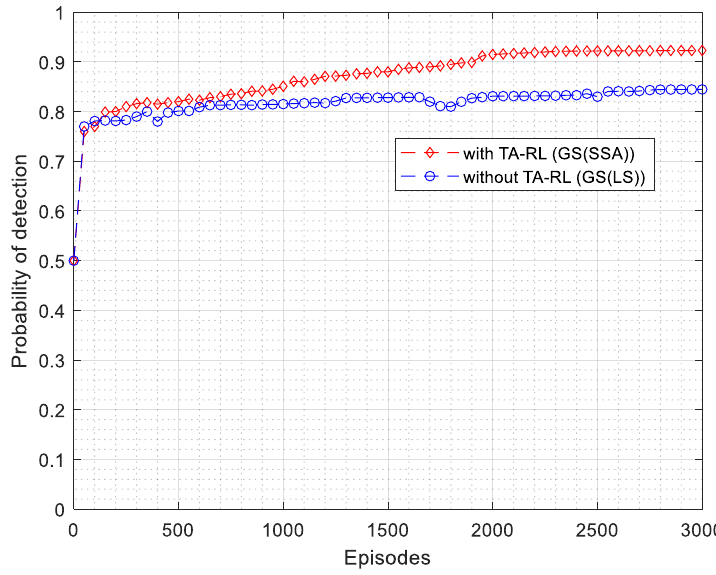
Figure 14. Improvement of 𝑃𝑑 during TA-RL-based CSS.